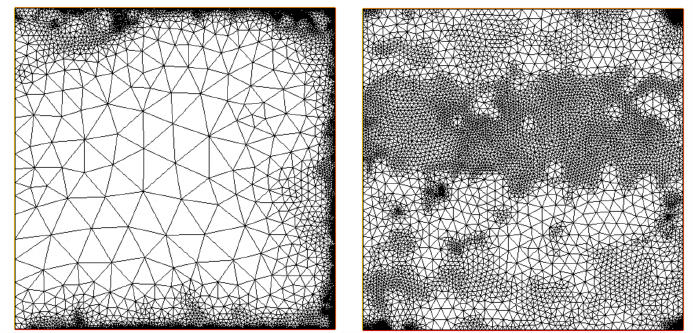
Figure 23. Example 4. ( Left ) The final mesh obtained with the gradient-based error estimator. ( Right ) The final mesh obtained with the Neumann auxiliary error